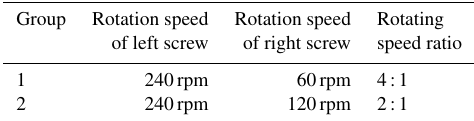
Table 6. Setting of rotation speed of the screw on both sides. Group Rotation speed